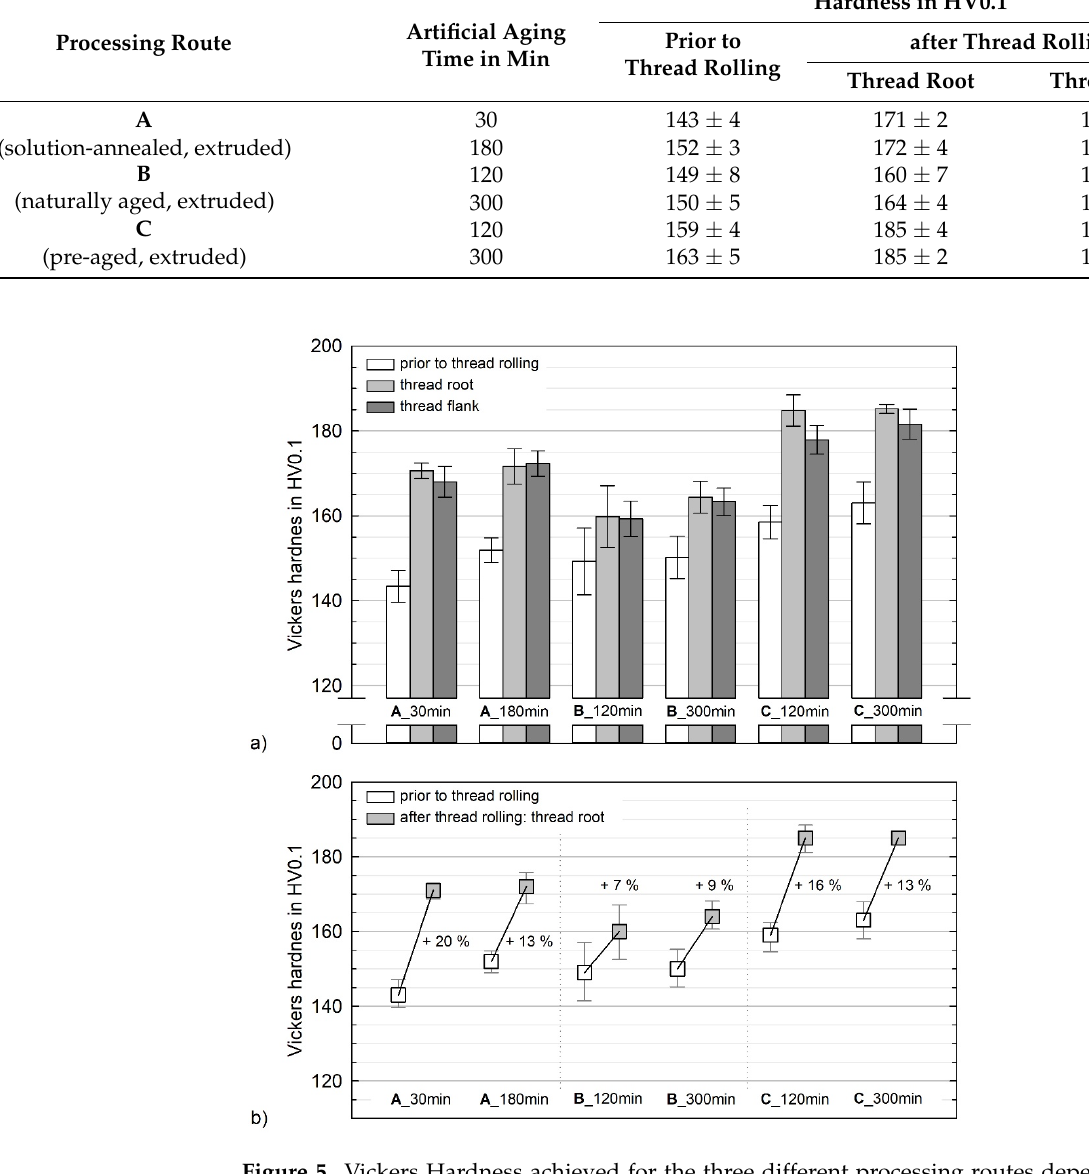
Figure 5. Vickers Hardness achieved for the three different processing routes dependent on the artificial aging time prior to and after thread rolling: ( a ) comparison between thread root and thread flank for each condition and ( b ) percentage increase in hardness by thread rolling. The highest hardness and percentage increase after thread rolling is achieved by processing route C. The distribution of Martens hardness over the longitudinal section of the threaded parts after thread rolling processed by the three different routes and artificial aging times chosen is shown in Figure 6. Each colored square stands for one indent and the local hard- ness. When the hardness is under 950 HM, the square is marked white, whereas a purple colored square displays a hardness over 1850 HM. Due to the spacing between single in- dents of 0.09 mm, in this graphically representation, the thread teeth seem somewhat de- formed missing a pronounced thread tip. However, to ensure the hardness measured is not influenced by indents being to close together, the grid of measuring points for scan- ning was not scaled down. The white, upper figure areas with low hardness are acrylic resin used for mounting the specimens. Further, the white area near the tip of the tooth and near the inner region of the stud processed after route A and aged for 30 min are mostly preparation or meas- urement artifacts (see Figure 5a). In accordance with the results of the Vickers hardness measurements shown in Figure 4, the threaded parts processed by route B (initial natural aging) exhibits the lowest hardness, when compared to the other routes. The highest hard- ness is achieved for the pre-aged conditions processed by route C. The scans clearly show